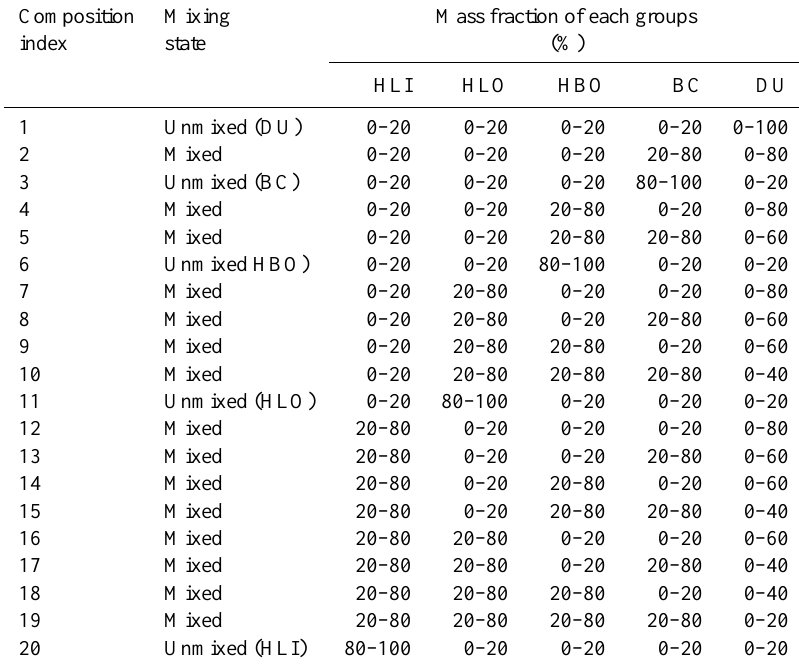
Table 1. 20 externally mixed particle compositions.